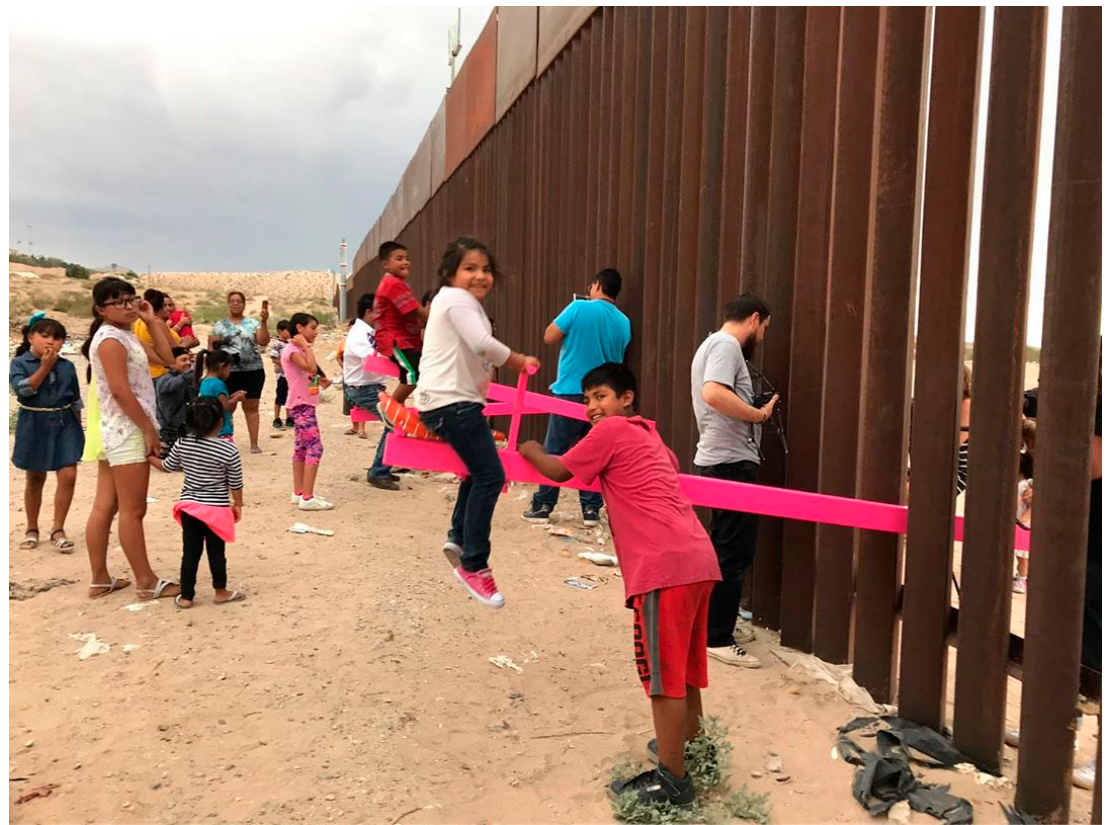
Figure 14. Two children play with installed teeter-totter (Photo graciously provided by Ronal